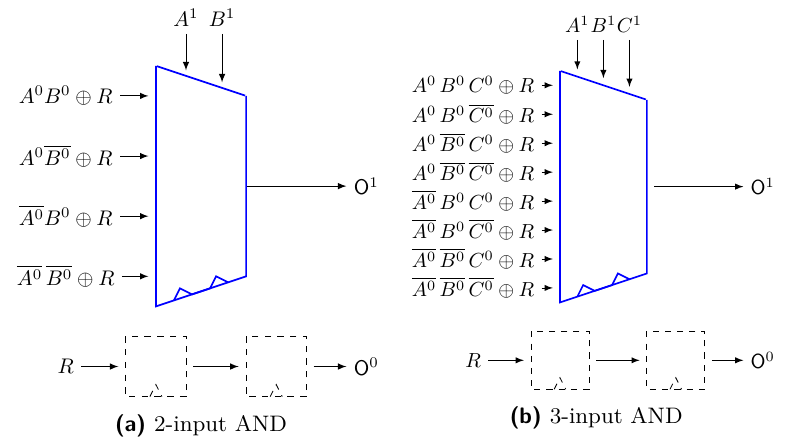
Figure 3: Examples for first-order PINI-secure GHPC